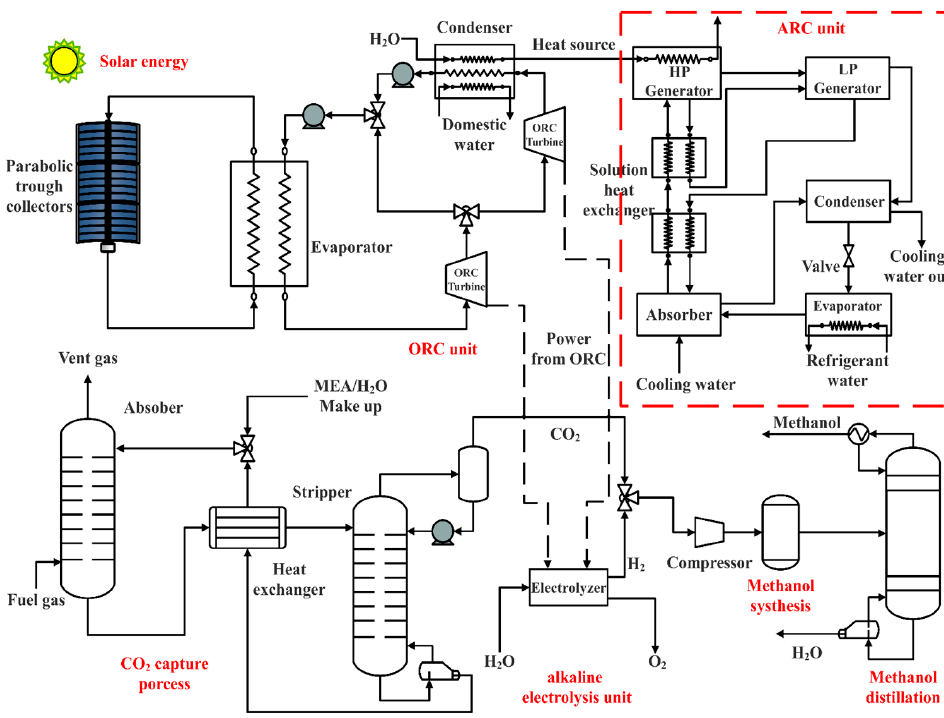
Figure 1. Flow chart of the proposed green poly-generation integrated system.